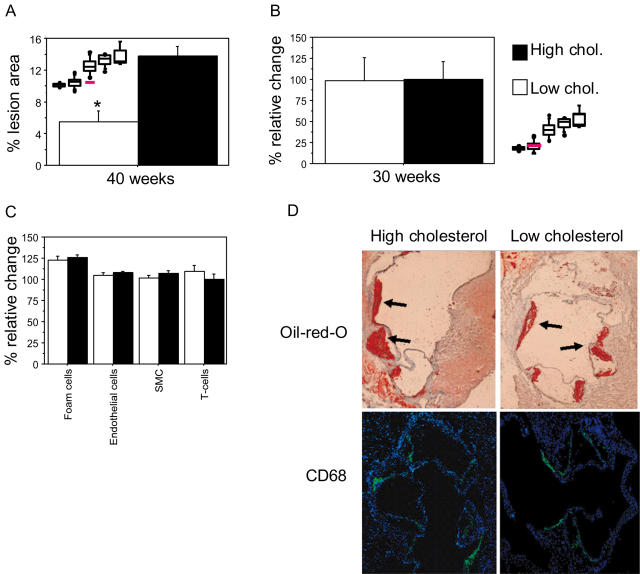
Effect of plasma-cholesterol lowering on lesion progression.Lesion surface area was determined as the percentage of lesion area in relation to the total area of pinned-out aortas from the bifurcation to the aortic root. At 28 weeks of age, mice received intraperitoneal injections of pI-pC to induce recombination of Mttp in the liver and were sacrificed 12 weeks later or 1 week after cholesterol lowering had been achieved. High-cholesterol control mice were injected with PBS. (A) At 40 weeks of age, lesion surface area in mice with low plasma cholesterol (i.e., pI-pC-treated, n = 7) had not progressed and differed significantly from that in high-cholesterol controls at 40 weeks (i.e., PBS-treated, n = 6) (*P<0.005). Figure 1A is shown for comparison; red line indicates mice with low plasma cholesterol. (B–D) One week of low levels of cholesterol (30-week-old mice) did not affect lesion size (P = 0.96), (B) Shown are percent relative changes in lesion area. Figure 1A is shown for comparison; red line indicates the low-cholesterol group. (C) The numbers of foam cells (P = 0.52), endothelial cells (P = 0.49), smooth muscle cells (P = 0.18) (SMC), and T cells (P = 0.34) and (D) the staining of Oil-red-O (upper panels) and fluorescence of anti-rat antibodies binding to rat anti mouse CD68 (lower panels) in representative sections isolated from the aortic root of high-cholesterol (left panels) and low-cholesterol (right panels) mice. Arrows indicate Oil-red-O stained lesions.